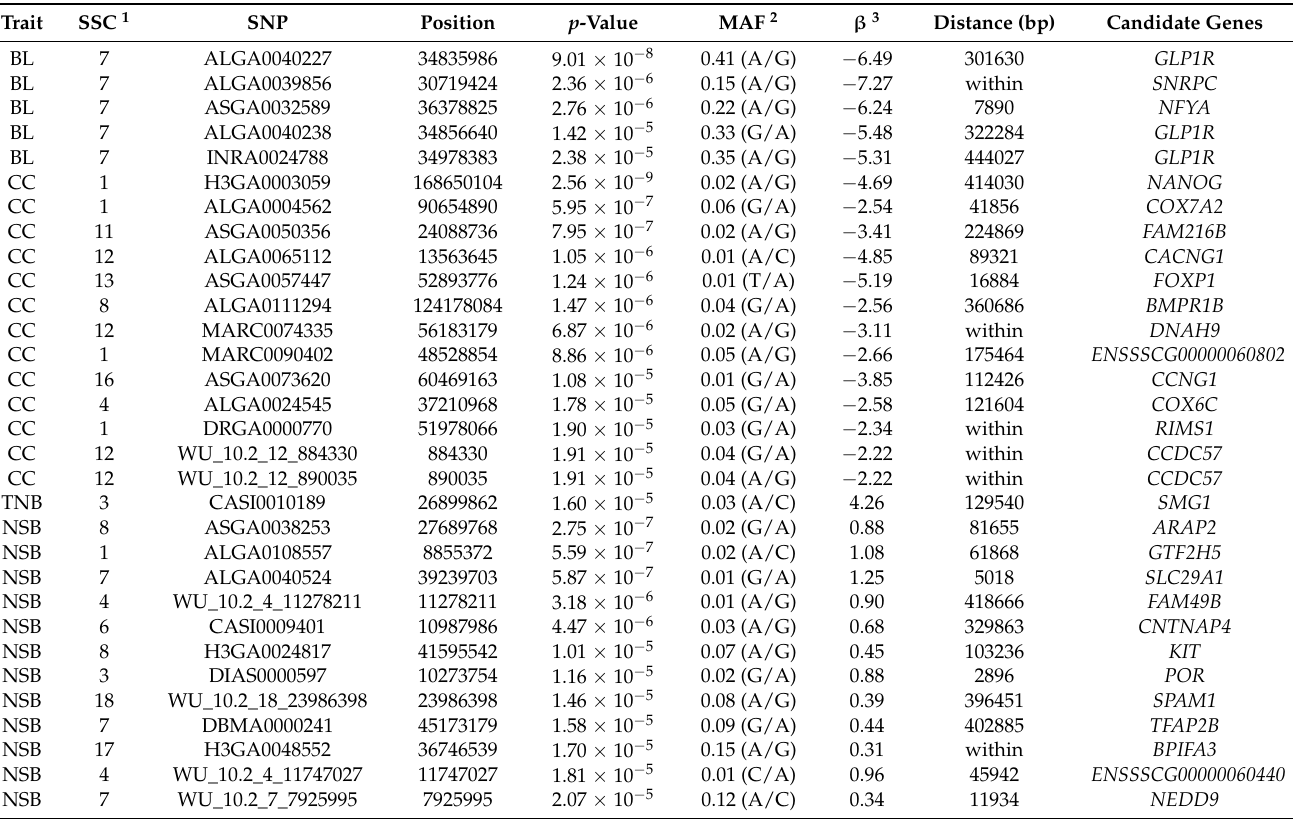
Table 2. Potential single-nucleotide polymorphisms (SNPs) and candidate genes identified by the genome-wide association study for body size and reproduction